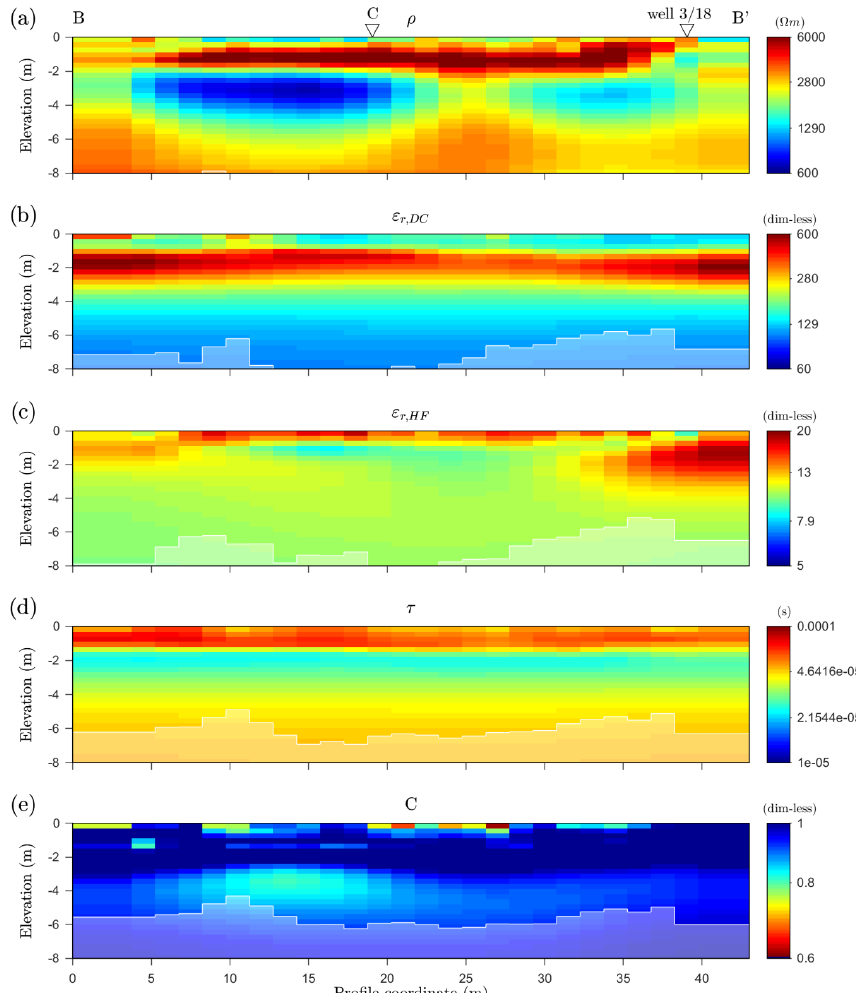
Figure 9. Two-dimensional inversion results for the profile of HFIP measurements at the Shestakovka River basin (B to B (cid:48) ), separately shown for each of the five Cole–Cole parameters (a–e) . The total data fit is χ = 1 . 9. Brighter areas mark zones of decreased reliability based on the depth of investigation (Fiandaca et al., 2015). The locations of the Schlumberger sounding (C) and the well 3/18 are marked additionally at panel